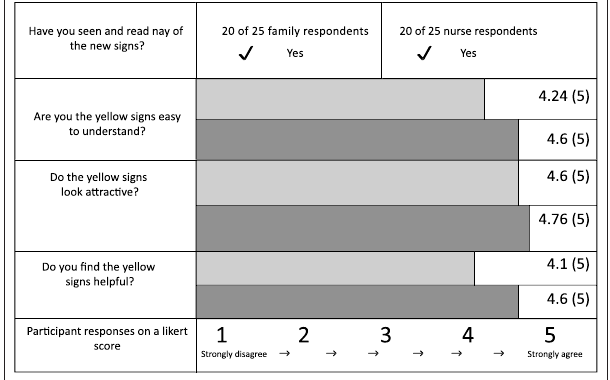
FIGURE 3: Rapid appraisal results – mean (median) scores represented.